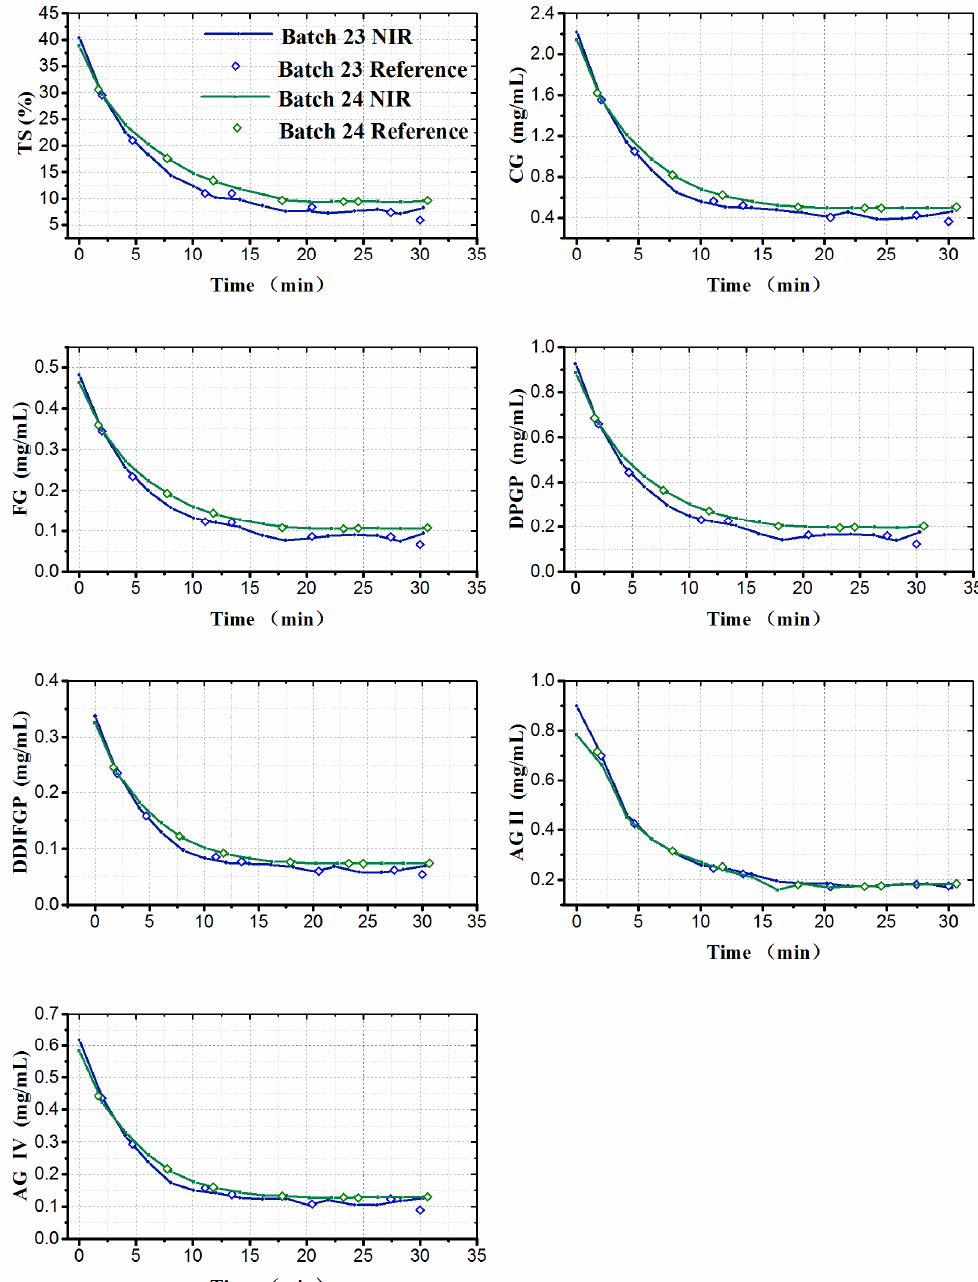
Figure 8. Robustness of the in-line NIR spectroscopy method. (* In-line monitoring results are shown as the lines, where the results of the randomly collected 7 samples were obtained via off-line reference methods).